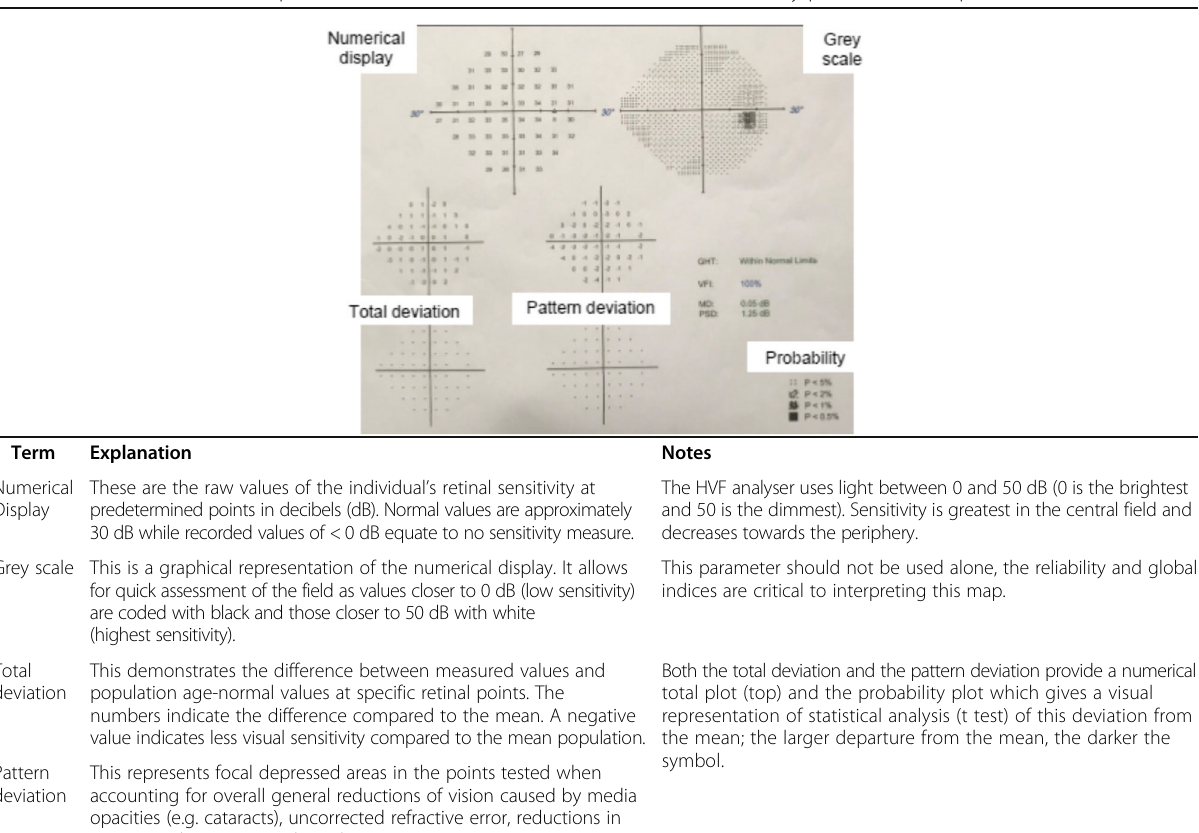
Table 2 Interpretation of Humphrey visual field plots. In static perimetry the stimulus is stationary but it changes its intensity until the sensitivity of the eye at the particular point is found. It is measured at preselected locations in the visual field. Most IIH patients have a threshold test where steps of 4 dB are used until detected then re-tested at every point in 2 dB